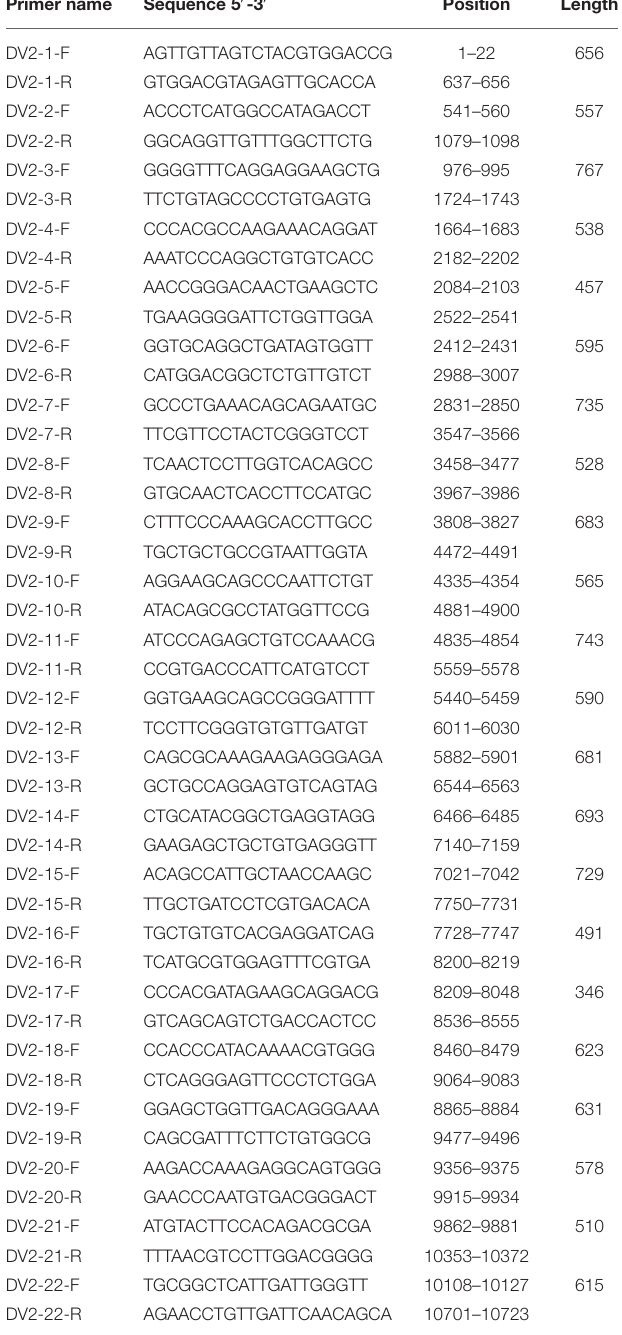
TABLE 1 | Primers used for the complete genomic characterization of